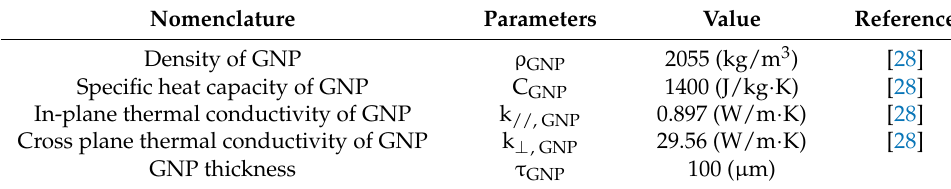
Table 3. Thermo-physical parameters of GNP layer used in the